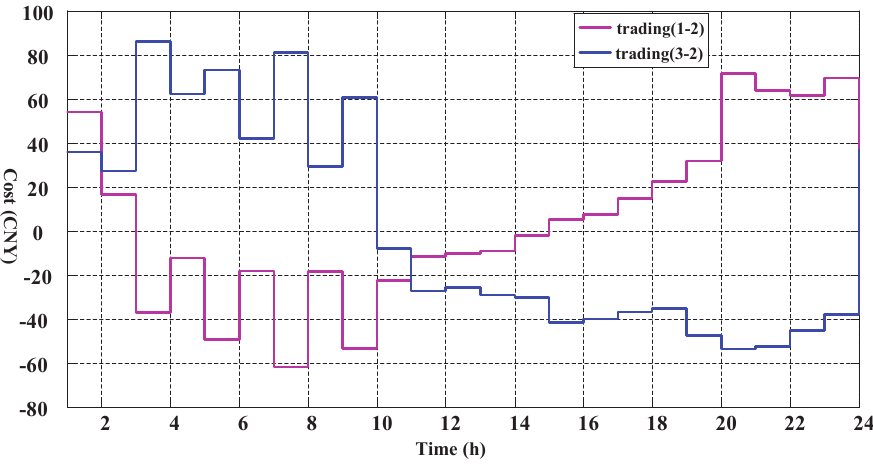
Figure 8. Results of cost transactions between MGs.